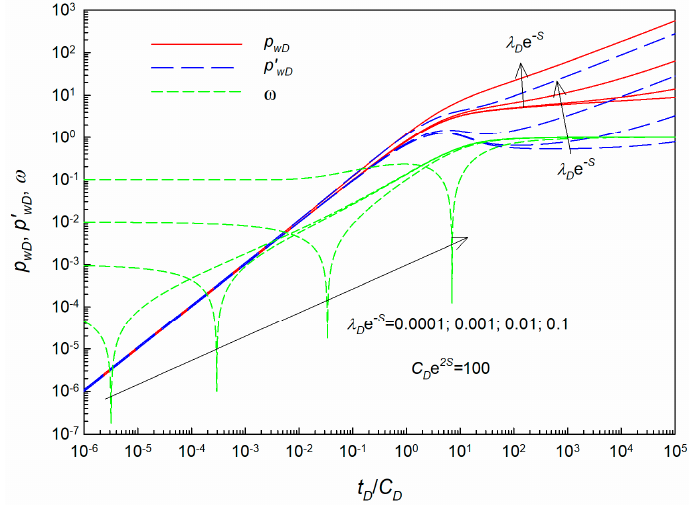
Figure 9. Effect of λ D e -S on the new type curves for non-Darcy flow model.